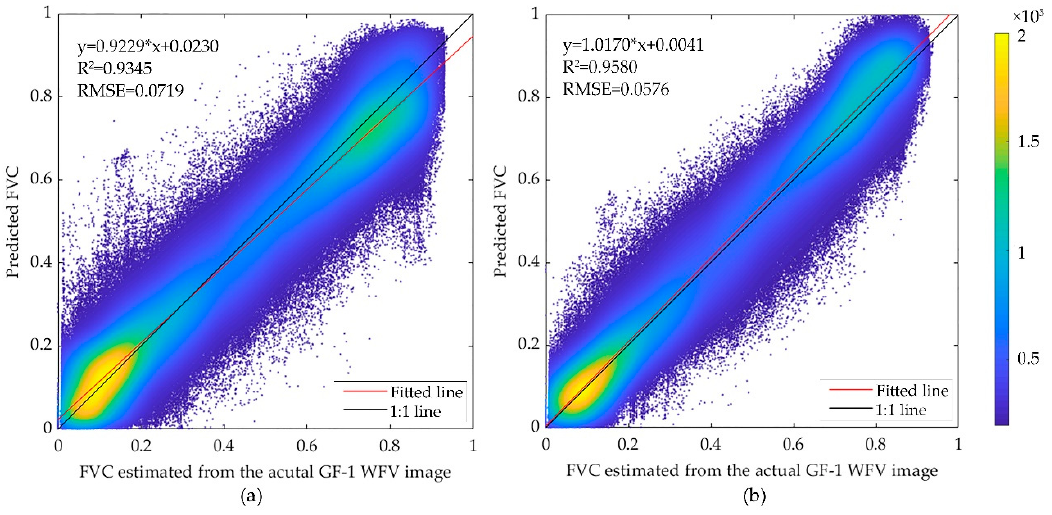
Figure 10. Density scatter plots of the FVC estimated from the actual GF-1 WFV data and the prediction generated by the strategy of fusing reflectance data (FC) ( a ) and the strategy of fusing derived FVC data (CF) ( b ). Table 6. Information of the experimental data